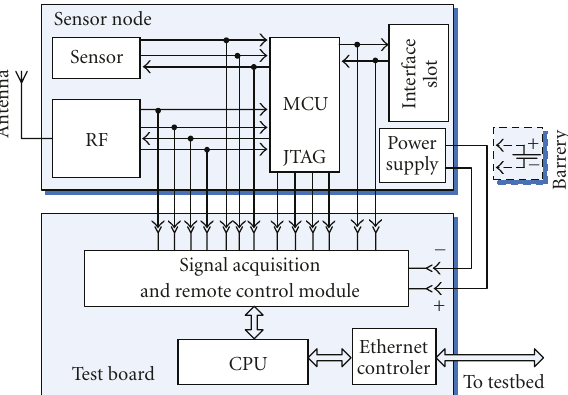
Figure 6: System architecture of HINT.